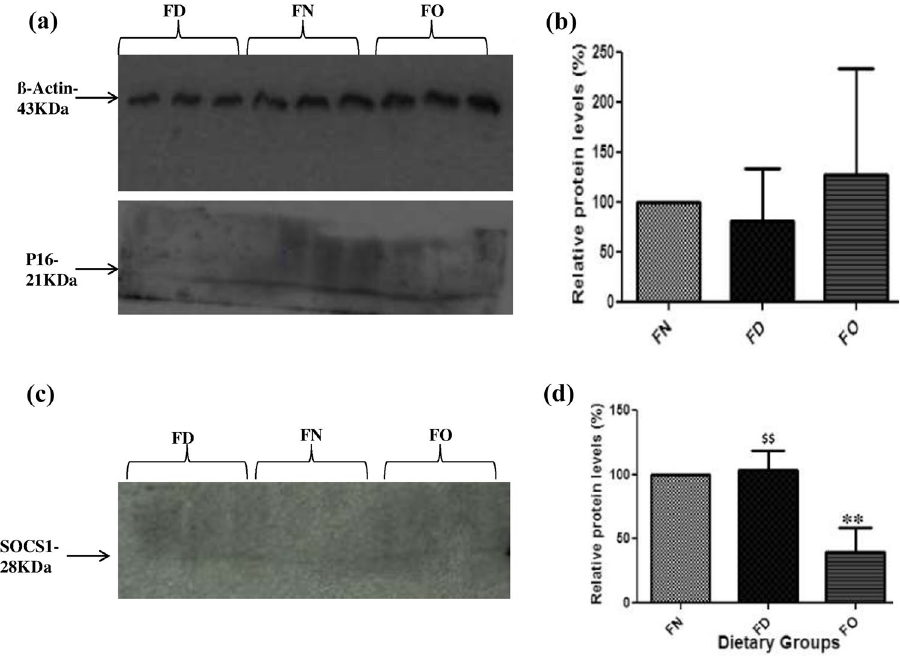
Figure 6. Effect of folic acid deficiency and oversupplementation on protein expression in HepG2 cells ( a ) Representative images of β-Actin & p16 blot ( b ) Densitometric analysis of the p16 blot. ( c ) Representative image of SOCS1 blot ( d ) Densitometric analysis of the SOCS1 blot. ** P < 0.01 versus FN, $$ P < 0.01 versus FO;